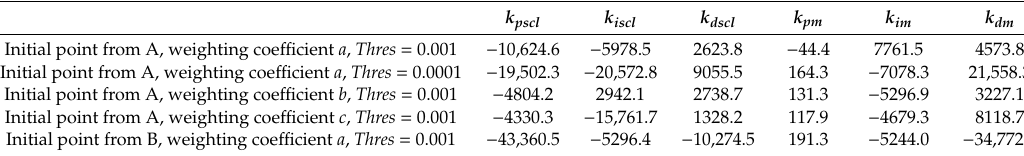
Table 2. PID parameters derived by